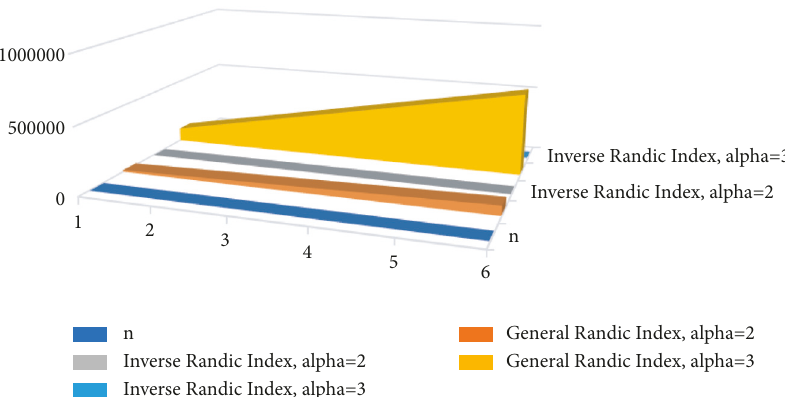
Figure 5: Comparison of R